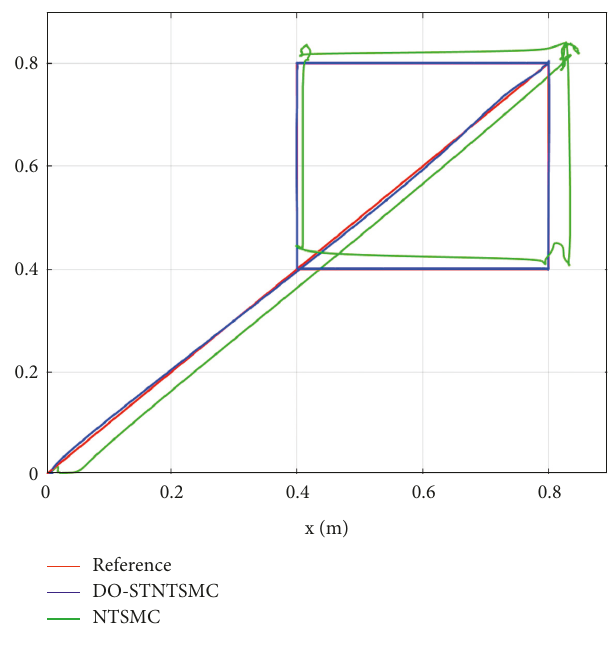
Figure 9: Trajectory tracking in 2D space.